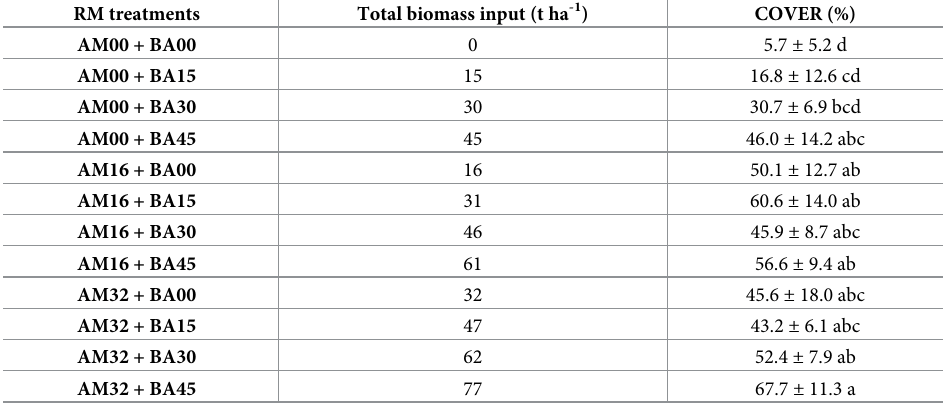
Table 2. Mean values and standard deviation for ground vegetation cover (COVER) across the restoration man- agement (RM) treatments. Mean followed by the same letter do not differ significantly by Tukey test (p <